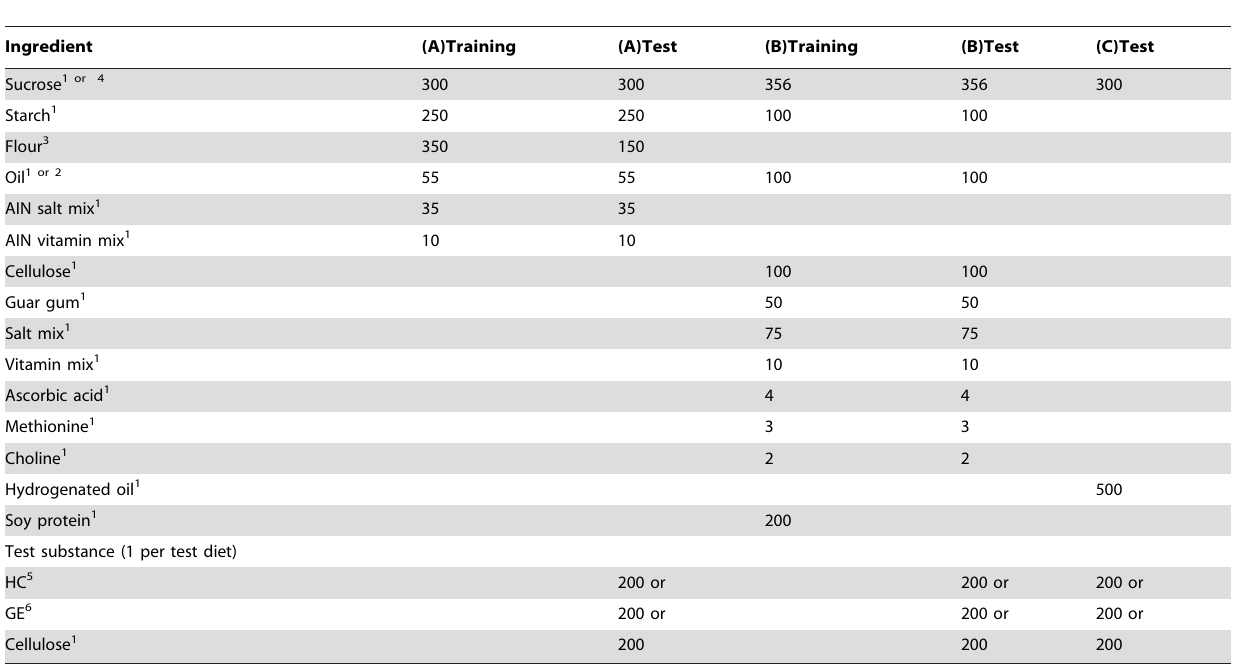
Table 4. Composition of training and test diets (g/kg; A, B, or C diets used depending on species).